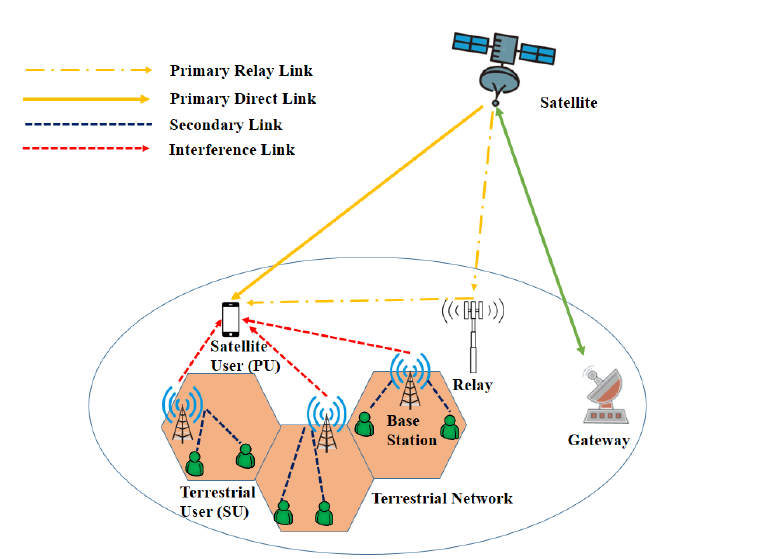
Figure 5. Cognitive